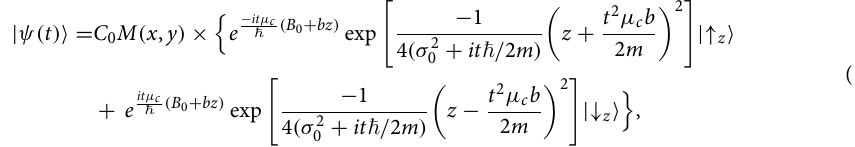
φ Paris ( x ) φ Tokyo ( x ) = +